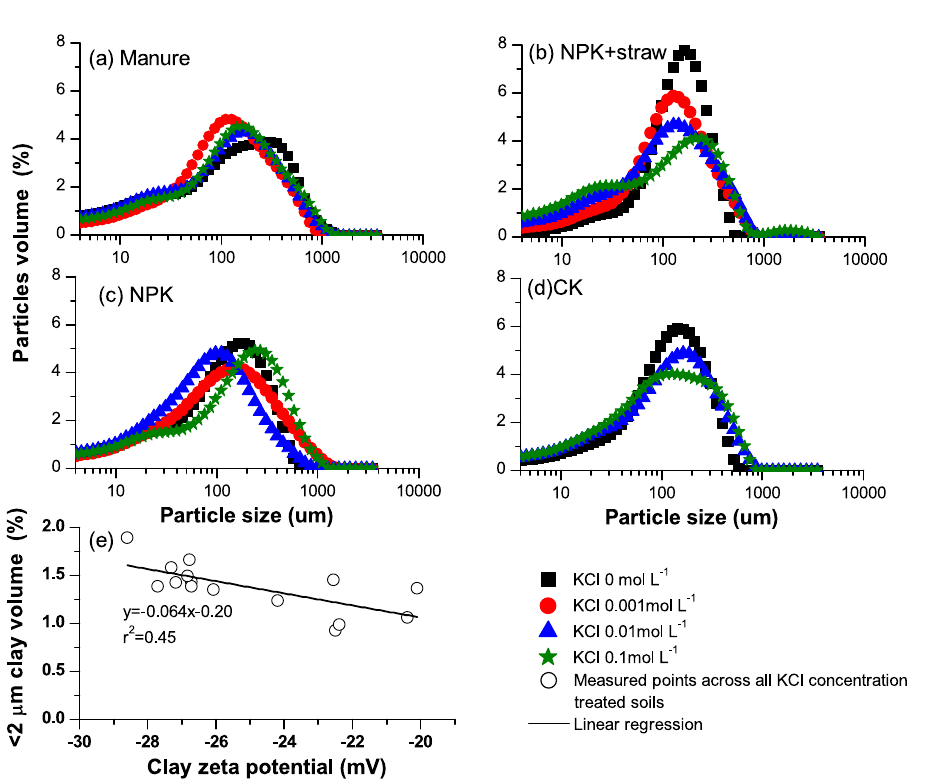
Figure 6. Grain size distributions with concentration by laser diffraction under different fertilizations, including ( a ) Manure, ( b ) NPK + straw, ( c ) NPK, ( d ) CK. Data for CK under 0.001 mol L −1 was lost. ( e ) Regression relationship between particles (< 2 μm) and clay zeta potential across all fertilization